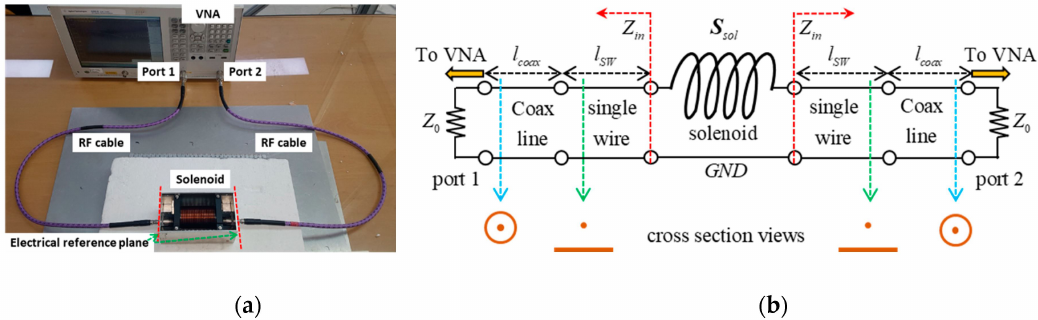
Figure 5. Measurement for prototype solenoid. ( a ) A picture of the two-port measurement setup